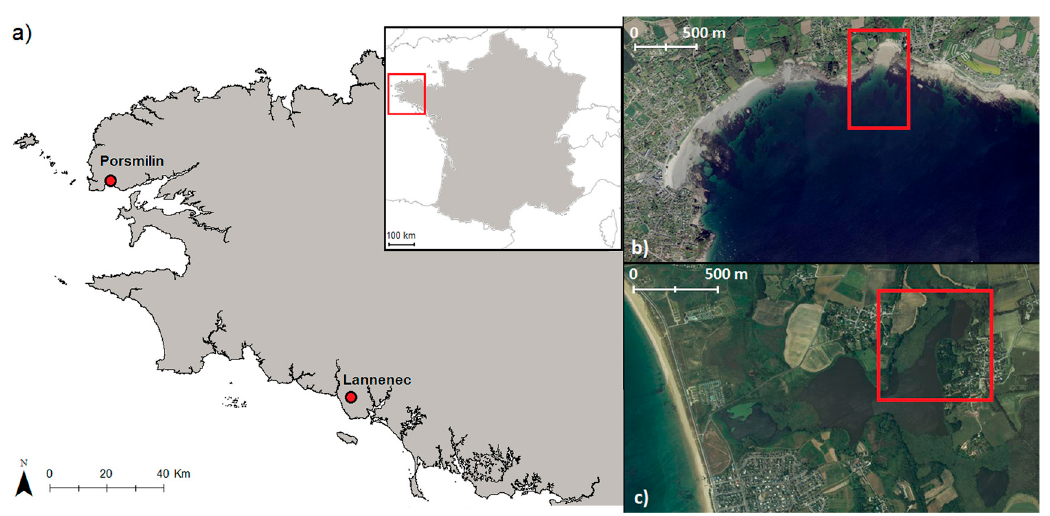
Figure 5. ( a ) Location of the study sites. ( b ) Aerial view of Porsmilin Beach (Geoportail IGN© image). ( c ) Aerial view of Lannénec Pond (Geoportail IGN© image). The red rectangles outline the study areas (displayed in detail in Figures 6 and 7). Remote Sens. 2018 , 10 , x FOR PEER REVIEW